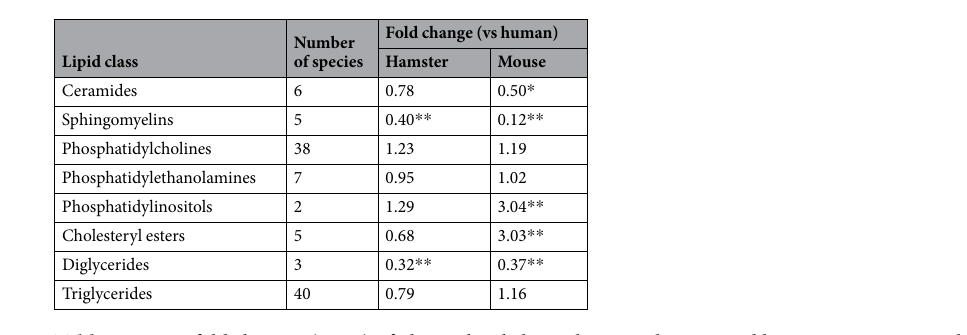
Table 3. Mean fold changes (n = 6) of plasma lipid classes between human and hamster or mouse. Values